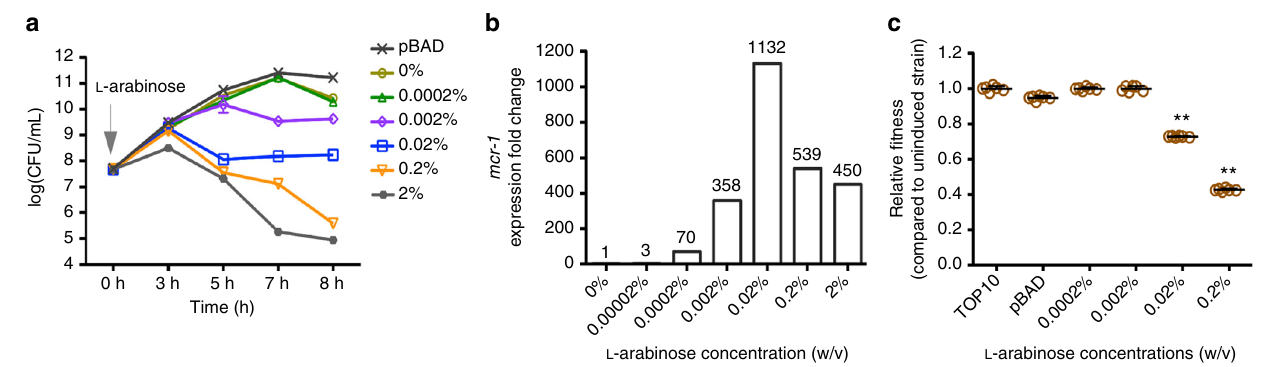
Fig. 2 Effects of mcr-1 overexpression on bacterial growth and fi tness in vitro. a Overproducing mcr-1 causes variable effects on growth rate depending on the concentrations of L -arabinose ( n = 3). b The expression levels of mcr-1 gene induced by increasing concentrations of arabinose were measured by qRT- PCR ( n = 2). c Relative fi tness of mcr-1 overexpressing strain mcr-1 /pBAD competing control strain pHT315 under increasing concentrations of L -arabinose (0.0002% vs 0%, 0.002% vs 0%, 0.02% vs 0%, 0.2% vs 0%). Error bars represent the SD ( n = 6). The differences in fi tness were tested using non- parametric Mann – Whitney test, ** indicates the p values is < 0.05. The average relative fi tness and p values are listed in Supplementary Table outer membrane 9 . We employed transmission electron microscopy (TEM) and study the cellular morphology of E. coli (TOP10) under induced (0.2% (w/v) L -arabinose) and non-induced conditions (Fig. 3). Both control strains, E. coli TOP10 with pBAD minus mcr- 1 , and E. coli TOP10 ( mcr-1 /pBAD) without L -arabinose induction, showed normal cellular characteristics with a multi-layered cell surface consisting of a distinct, structured outer membrane, a peptidoglycan layer in the periplasmic space, a normal cytoplasmic membrane and typically granular cytoplasm (Fig. 3a and Fig. 3b). Signi fi cant morphological changes were however, observed in E. coli TOP10 ( mcr-1 /pBAD) treated with 0.2% L -arabinose for 8 h (Fig. 3c). In particular, with the outer cell membrane cell envelope (Fig. 3f). The outer membrane region exhibited altered structural integrity, varying markedly in thickness and density, and it could not be differentiated from the cell wall or the cytoplasmic mem- brane (Fig. 3d – f). TEM analysis on E. coli where mcr-1 is over- expressed shows other gross cellular changes including complete loss of the ‘ bacilli ’ morphology and absence of electron-dense material appeared as empty ‘ ghost ’ cells (Fig. 3c). By comparison, E. coli TOP10 with pBAD minus mcr-1 , and E. coli TOP10 ( mcr-1 / pBAD) without L -arabinose induction possess homogeneous elec- tron densities in the cytoplasm and exhibited unaltered multi- layers of cell membrane (Fig. 3a, b) con fi rming that it is the high- level expression of mcr-1 that has induced these gross morpholo- gical changes. In order to rule out effects caused by high con- centration of L -arabinose, we examined E. coli TOP10 with pBAD alone (minus mcr-1 ) with 0.2% L -arabinose induction (Supple- mentary Fig. 3). Induction resulted in an intact cell wall with a well-de fi ned inner and outer membrane, and a highly homo- geneous electron density in cytoplasm were observed (Supple- mentary Fig. 3), further supporting that cell membrane impairment is due to the expression of mcr-1 gene only.